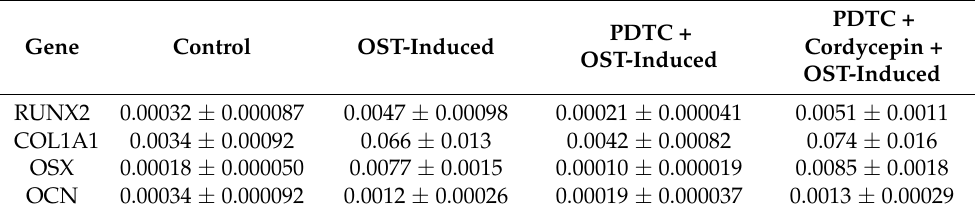
Table 5. Relative expression of osteogenesis related genes in the DPSC following treatment with